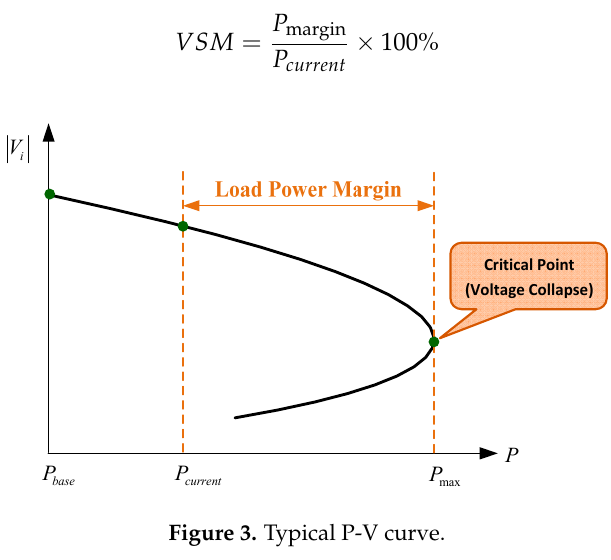
Figure 3. Typical P ‐ V curve. Figure 3. Typical P-V